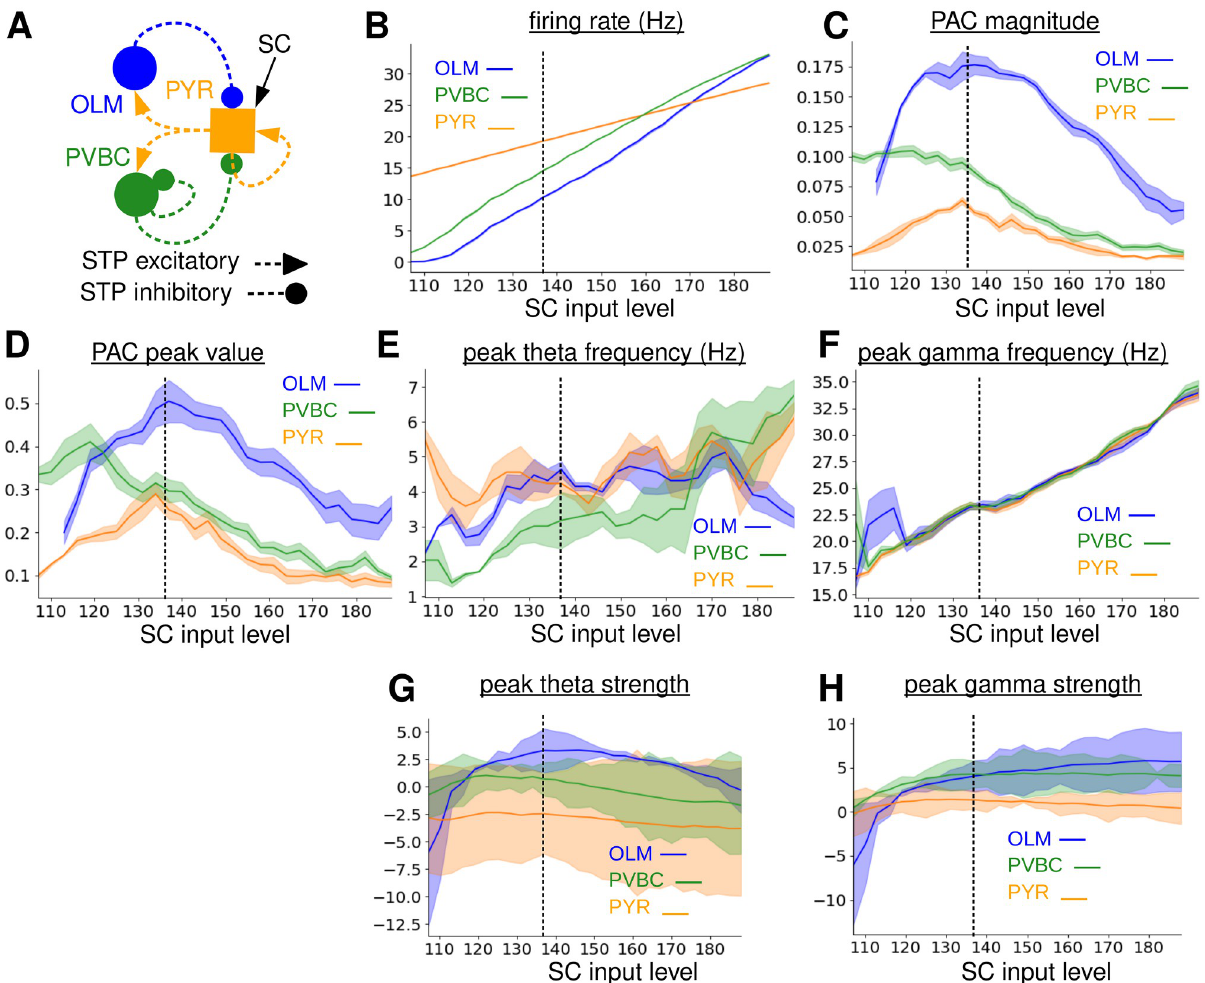
Fig 3. Dependence of TSGPAC on SCIL in the 480 PYR, 20 OLM, 20 PVBC cell full model, (FM). (A) Schematic of the circuit . (B) Population firing rates . (C) Total PAC magnitude in the theta, 1-12 Hz, band and slow-gamma, 12-50 Hz, band . (D) Peak PAC value . (E) Peak theta frequency. Location of power spectrum peak in 1-8 Hz band . F Peak gamma frequency. Location of power spectrum peak in 15-50 Hz band . (G) Theta strength. Log of theta band power spectrum peak size. (H) Gamma strength. Log of gamma band power spectrum peak size . (B-H) Shaded bands show SEM in the plotted values across two identical simulations with random configurations. Dashed vertical line indicates the simulation shown in Fig 2.